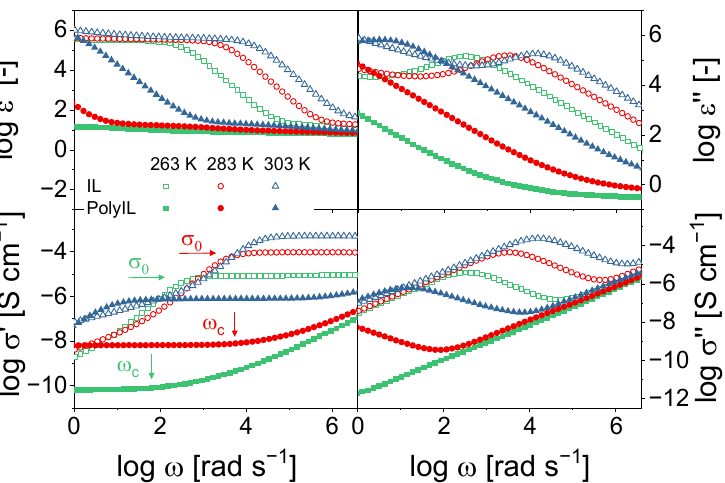
Figure 2. The real and imaginary part of the complex permittivity ( (cid:101) (cid:48) and (cid:101) (cid:48)(cid:48) ) and the real and imaginary part of the complex conductivity ( σ (cid:48) and σ (cid:48)(cid:48) ) as a function of the angular frequency at three representative temperatures for the IL, open symbols, and the polyIL, closed symbols. The ionic conductivity ( σ 0 ) and the rate of charge transport ( ω c ) are indicated in the real part of the conductivity ( σ (cid:48) )